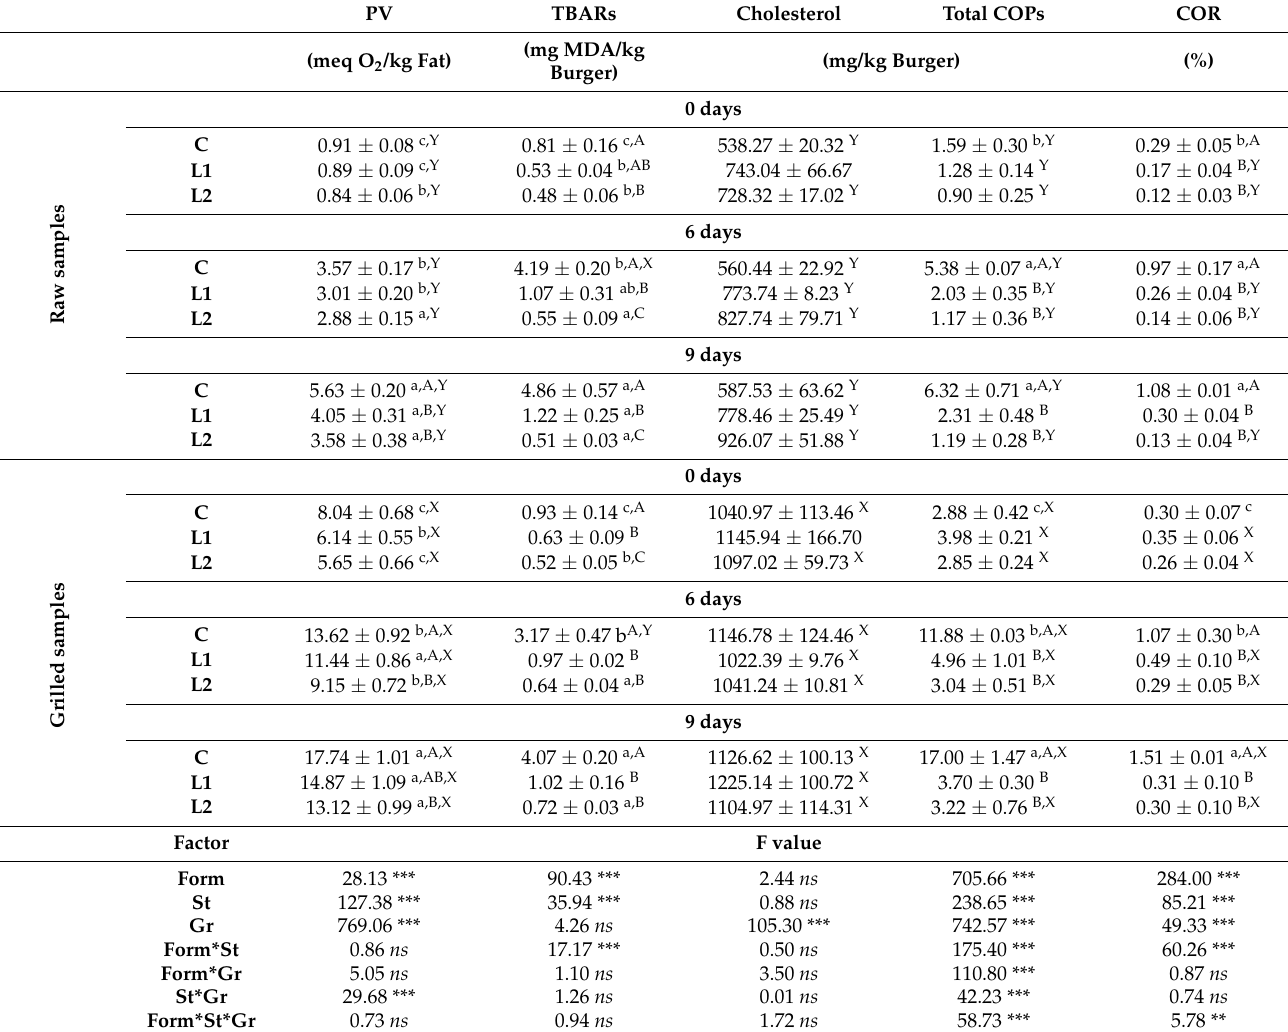
Table 6. PV, TBARs, cholesterol, total COPs, and COR of raw and grilled hamburgers after 0, 6, and 9 days of storage. C, control (minced beef meat + maltodextrine + starter cultures); L1, minced beef meat + starter cultures + 87.5 mg phenols/kg of meat; L2, minced beef meat + starter cultures + 175 mg phenols/kg of meat.